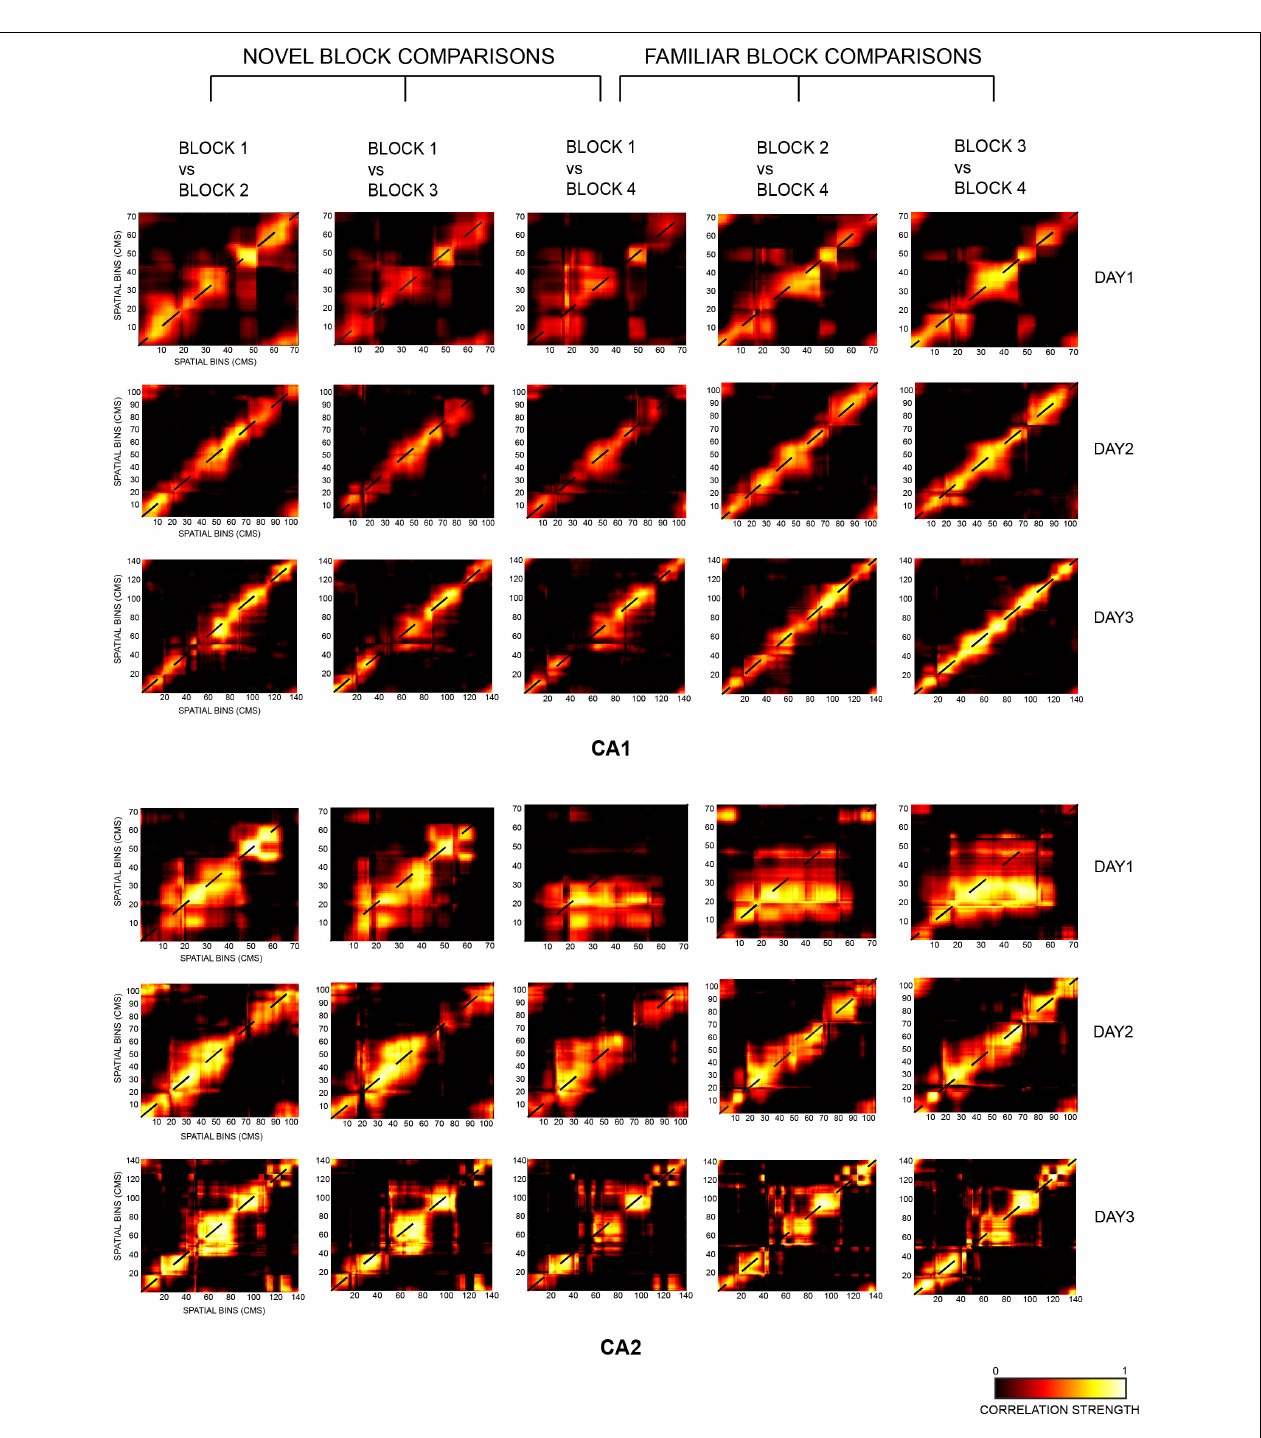
FIGURE 4 | Two-dimensional population correlation matrices for CA1 and CA2 ensembles were constructed for days 1, 2, and 3 with respect to the most novel session of each day, i.e., block 1 (termed as novel block comparison, consisting of block 1 vs. block 2, block 1 vs. block 3, and block 1 vs. block 4 comparisons) and the most familiar block of each day, i.e., block 4 (termed as familiar block comparison, consisting of block 1 vs. block 4, block 2 vs. block 4, and block 3 vs. block 4 comparisons). Highest spatial correlation was seen on the diagonal of all matrices, indicated in yellow (except for block 1 vs. 4 for CA2 on day 1 due to small number of neurons recorded in block